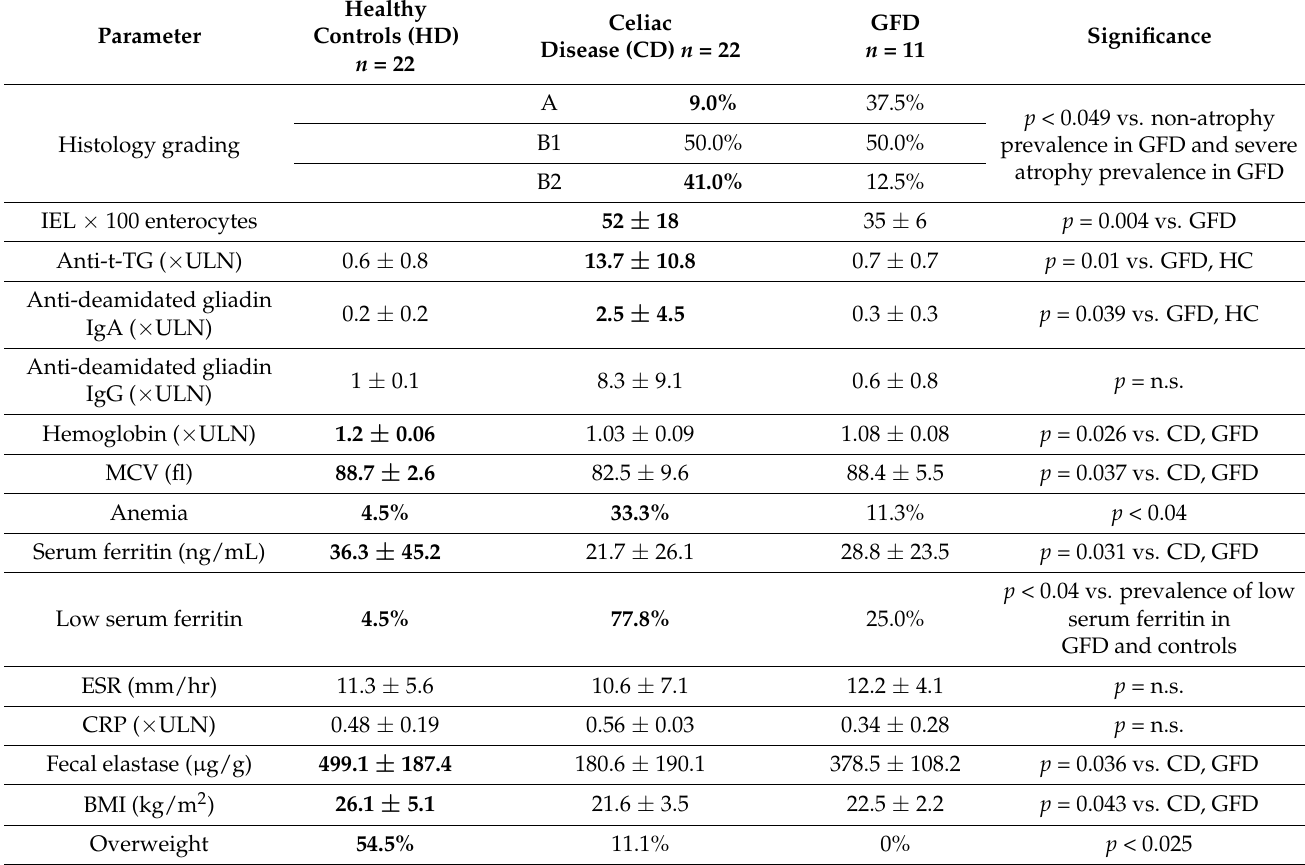
Table 2. Histological and laboratory findings 2